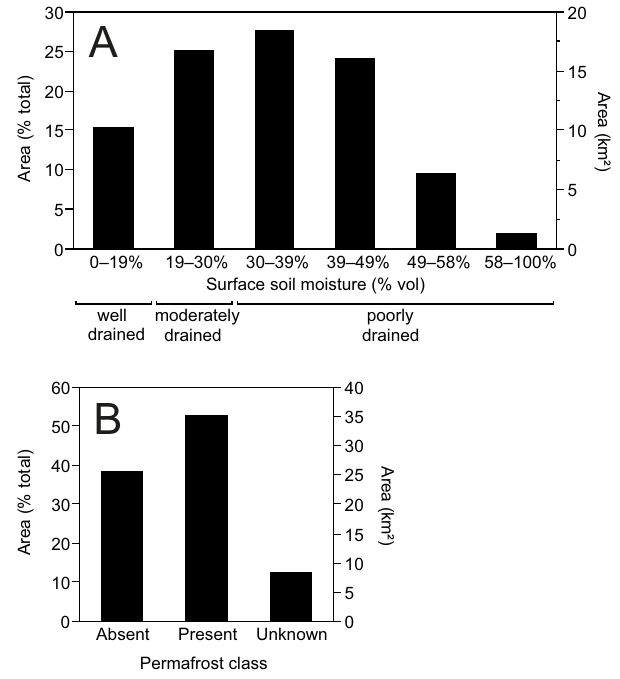
Figure 9. Distribution of mapped ( A ) drainage and ( B ) permafrost